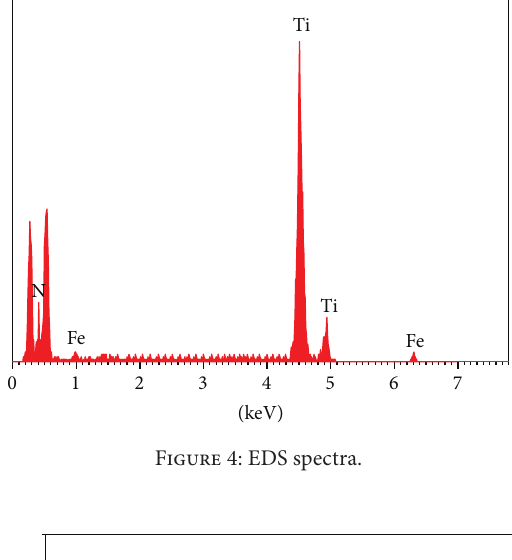
Figure 7: Degradation ratios of formaldehyde, ammonia, and benzene.